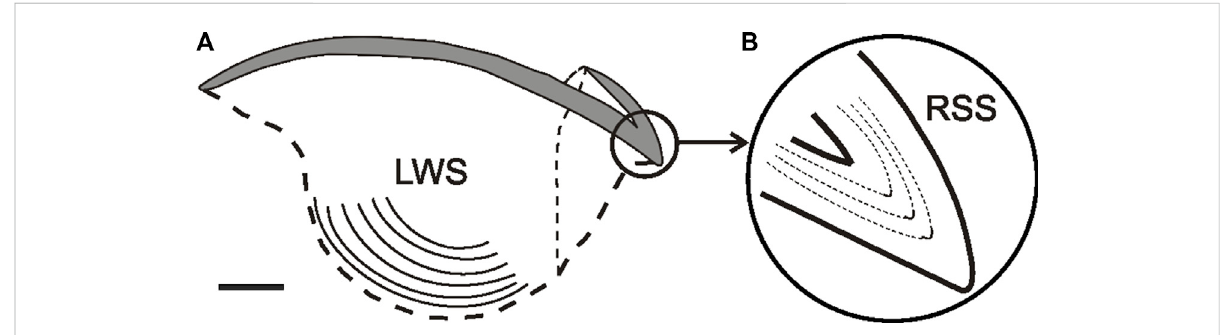
FIGURE 3 Lateral view oftheupper beakin Octopusvulgaris (A) Sagittal sectionshowingtheinner lateral wallsurface(LWS) bearing increments (lines). (B) Rostrum sagittal section magni fi ed and showing the daily increments. From Perales-Raya et al. (2014a); copyright permission obtained. Bar: approx. 2